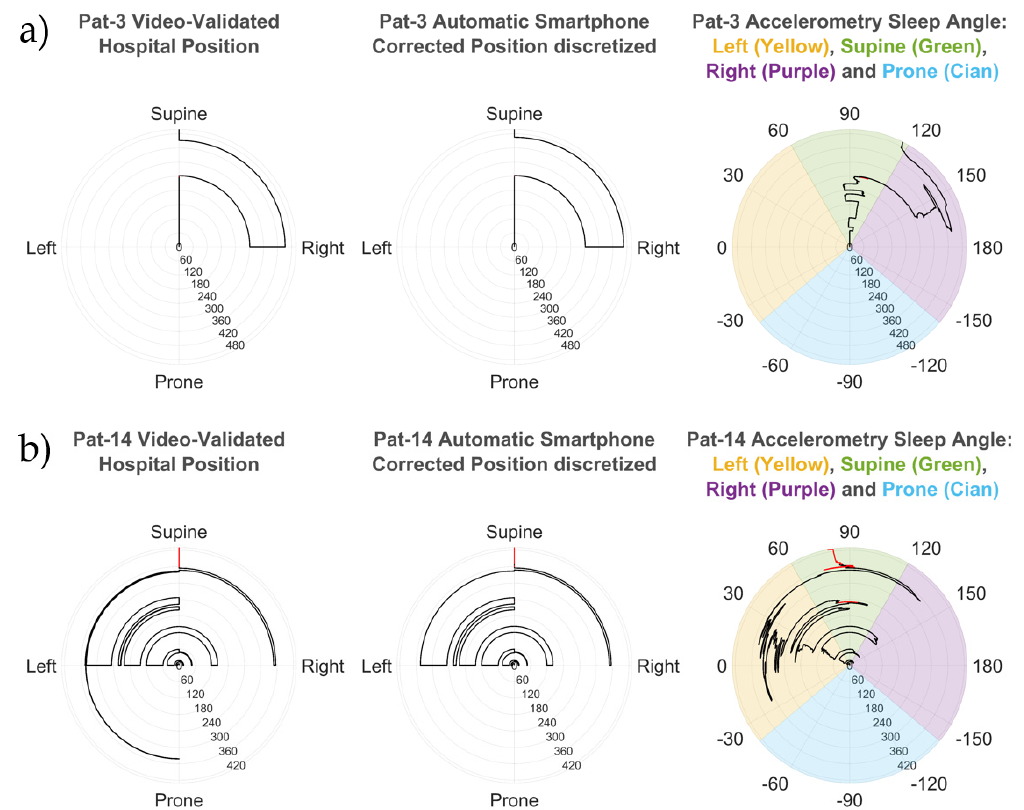
Figure 2. Patient 3 ( a ) and patient 14 ( b ) comparison between the hospital video-validated position (left polar plot in both patients) and the automatic smartphone corrected position (center polar plot in both patients) discretized from the accelerometry sleep angle (right polar plot in both patients). All polar plots indicate time in the radial axis (minutes) and position or angle value in the circumference. The stand position, if present, is displayed as a red line. The colored areas in the angle polar plots show the thresholds used to discretize the accelerometry sleep angle for the four different sleep positions (supine, prone, left, and right). The accelerometry angle correctly identifies all position shifts (even in difficult cases, such as patient 14), and provides patient sleep position with better resolution, which can reveal subtle angle variations not identifiable in the discretized positions (such as patient 3).